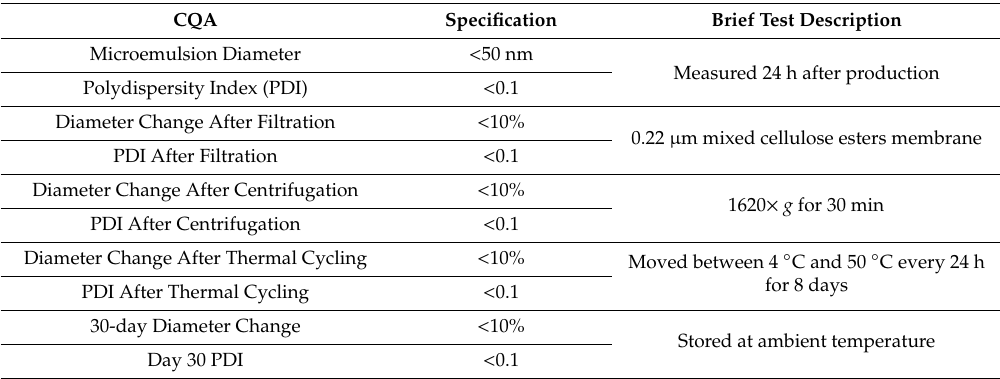
Table 1. Critical quality attributes (CQAs), specifications, and brief descriptions of how CQAs are measured. All diameter and PDI measurements were performed with dynamic light